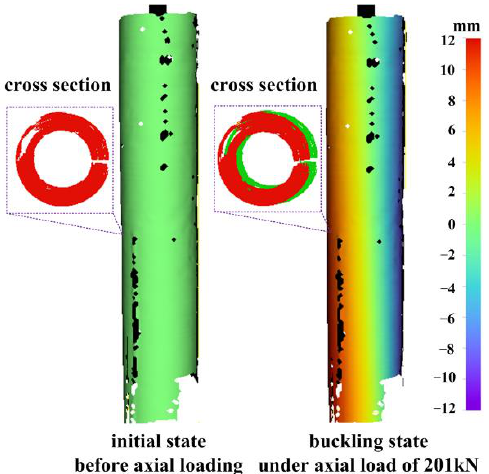
Figure 21. Full-circle lateral displacement field of the circular column under axial load.